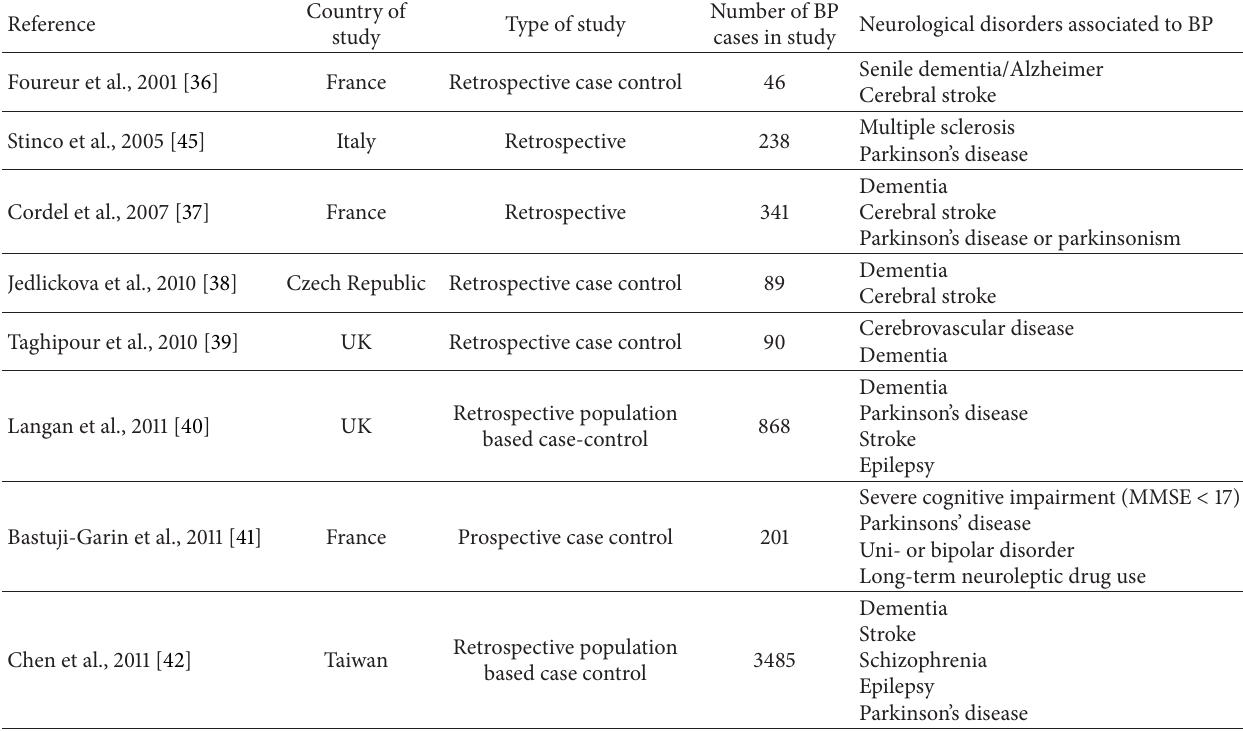
Table 1: Epidemiological studies linking bullous pemphigoid and neurological